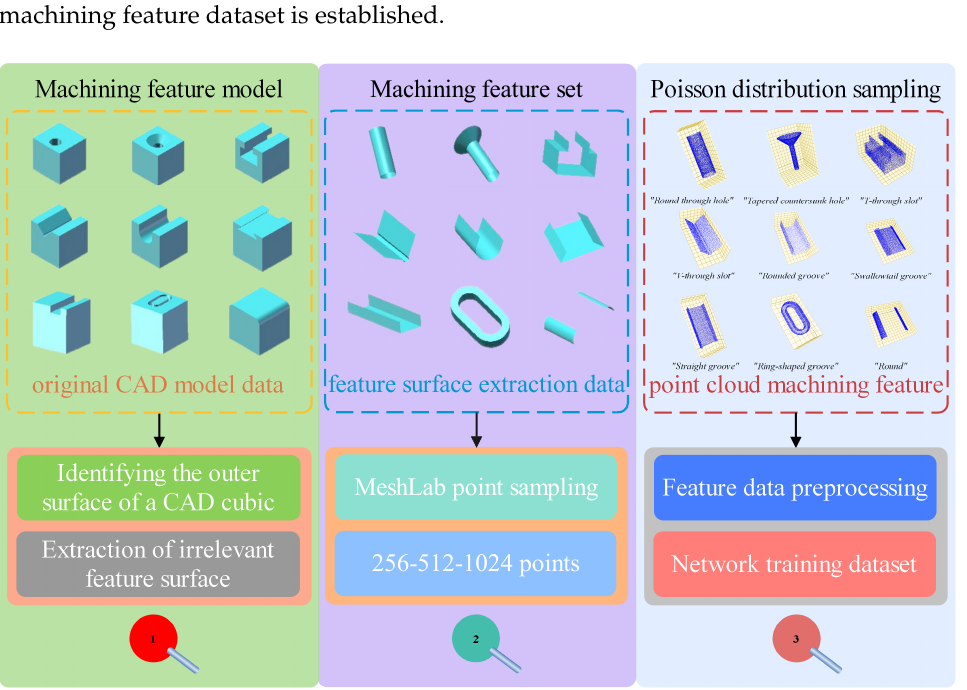
Figure 3. Flow chart of the point cloud machining feature dataset